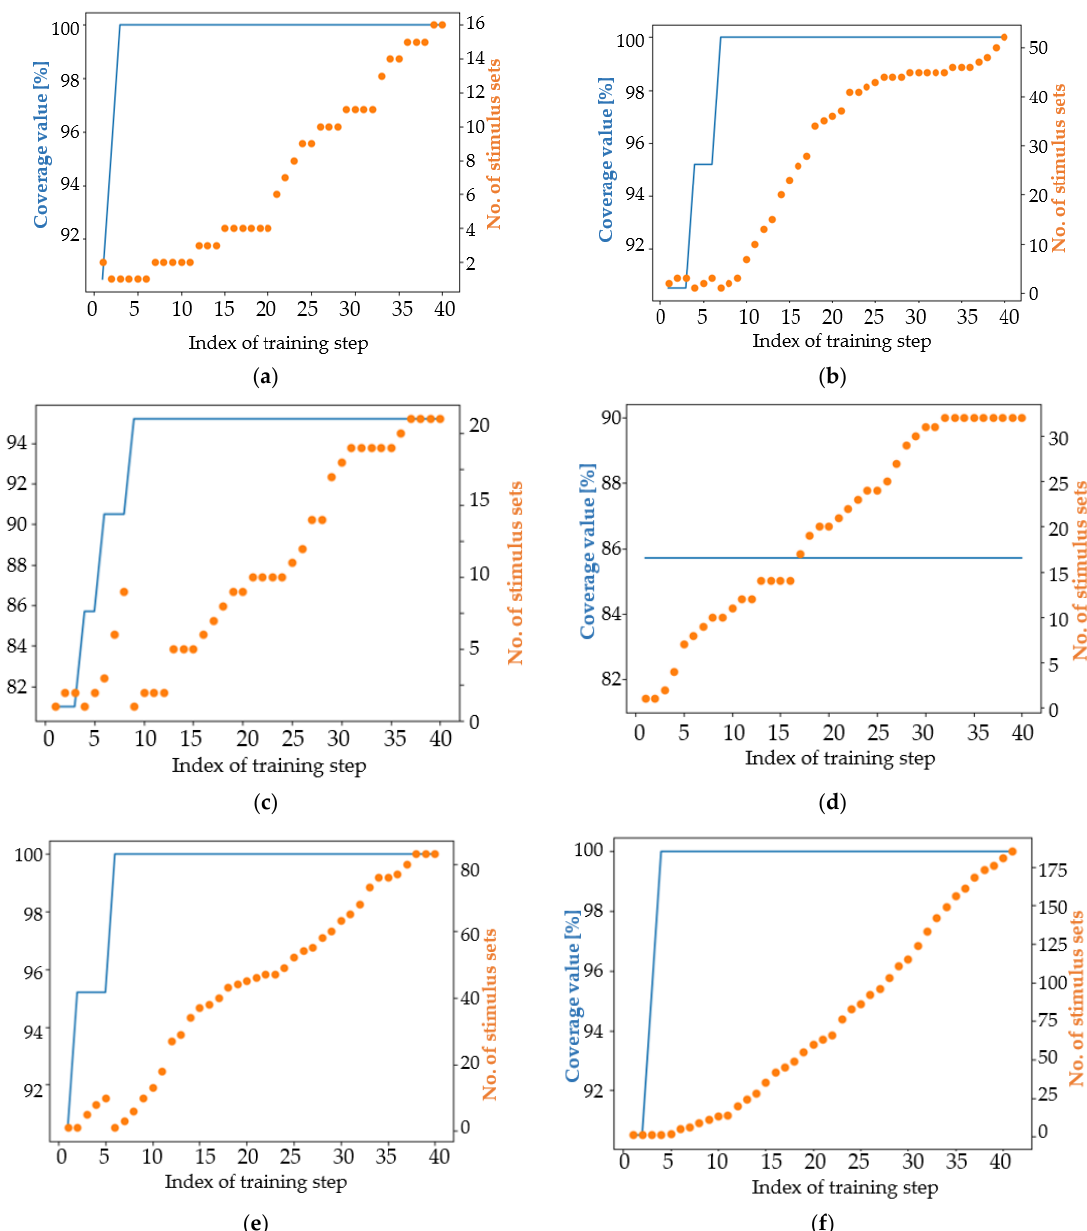
Figure 14. Training iterations when the mutation percentage equals 5%. The label “proposed” is attached to plots related to the approaches developed and proposed during current study. The blue line shows the coverage value reached by the best performing element in the population at that training step. The orange dots show how many individuals reached the highest coverage value met at each training step. For example, in sub-figure ( c ), at the sixth training step, the population contained three individuals reaching 90.5% coverage. For sub-figure ( c ), the best individuals in the initial population reached 81% coverage. For sub-figure ( d ), the best individuals in the populations at each training step reached 85.7% coverage. For sub-figures ( a , b , e , f ), the best individuals in the initial population reached a coverage of 90.5%. ( a ) V3.2 (proposed); ( b ) V3.21 (proposed); ( c ) V3.3 (proposed); ( d ) V3.6 (proposed); ( e ) SPEA2 [40] — Trial I; ( f ) SPEA2 [40] — Trial II. training iterations. As can be seen in the case of CPA (Figure 14a – d), there are generations the same training processes when the number of HPSS increases even by more than one unit. Additionally, the effect of randomness that characterizes genetic algorithms is well represented in Figure 14e,f. The same algorithm, when run a second time, doubled its performance. 4.2. Analysis of the Results in Terms of an Easier Coverage Target An achievable coverage goal related to the DUT functionality in question is to require each train to gain access to HIRS at least once per simulation when running a sequence of seven input combinations in each simulation. For this request, a sequence of 200 randomly generated stimulus groups was generated and run. This sequence is the exponent of the classical way of applying functional verification. After running the sequence, the 100% coverage value was met. Thus, for this simple coverage goal, if only one HPSS is needed, there is no need to use an advanced verification automation mechanism (e.g., genetic al- gorithm-based methods). However, for exemplification, genetic algorithm-based ap- proaches were tested. In the case of CPA, the mutation coefficient was calculated accord- ing to (1) and a predefined number of best parents are copied to the next generation. The results for the versions of genetic algorithms listed can be seen and compared in Figure 15. For the second coverage target, an interesting situation arises. Several models seem to be “resistant” to the generation of new HPSS. In Figure 15a,b,e,f,h, one can observe large periods where the number of stimulus sets remains constant. In contrast, approach V3.6 (picture d) has an almost linear increase in number of HPSS. This attribute is one of the factors that makes this approach a winner in solving the second coverage objective. For this target, approaches based on the NSGA-II algorithm have a low average perfor- mance both in terms of the number of stimulus sets that reach maximum coverage and in